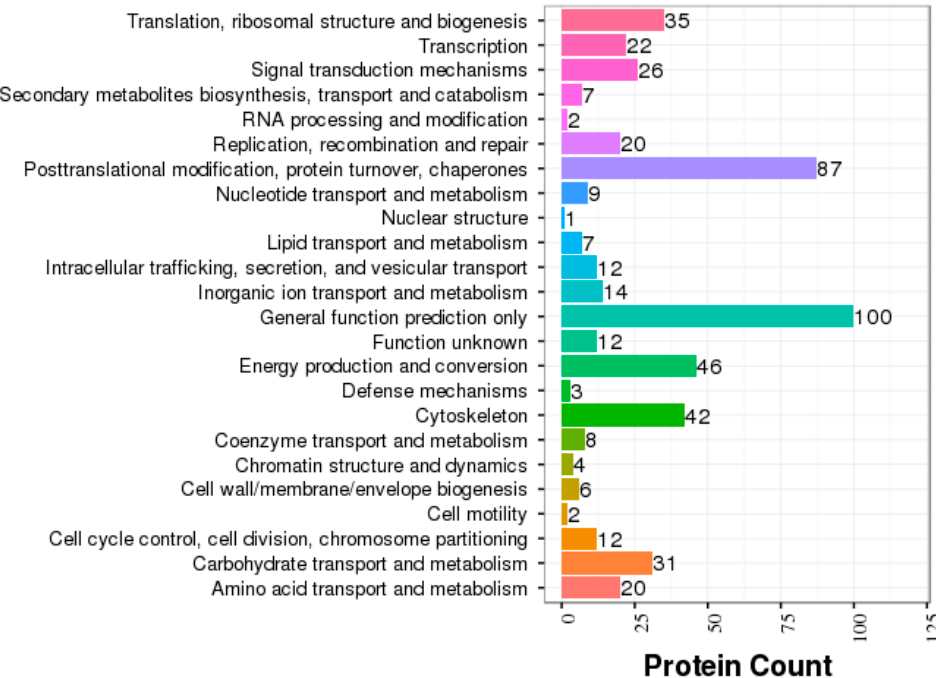
Figure 3. A bar chart of the COG analysis. The y -axis displays the COG term, and the x -axis displays the corresponding protein count, which illustrates the protein number of different functions. Table 1. The top 50 up-regulated skim milk proteins in HL